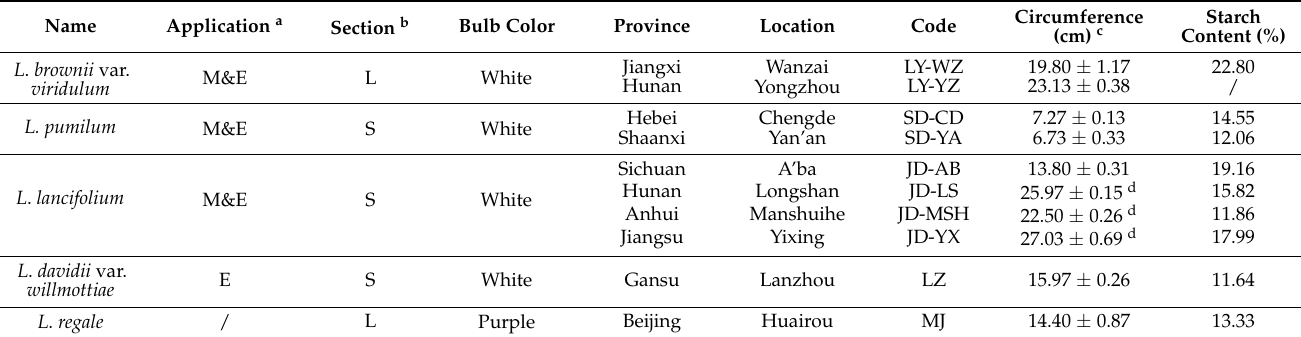
Table 1. Information of ten Lilium